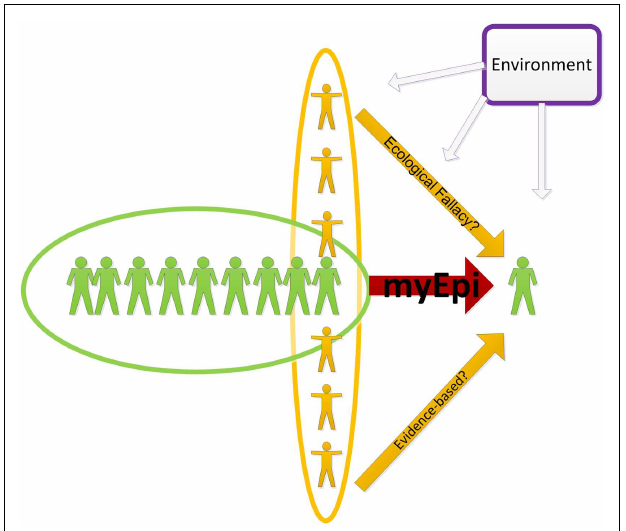
FIGURE 1 |An illustration of inferring to an individual form the population-level and individual-level data .The green “myEpi” oval denotes within-person data which could be also combined with information about blood relatives, social networks, as well as the entire population and the environment.The purpose of the analysis, however, is the individual-level inference.